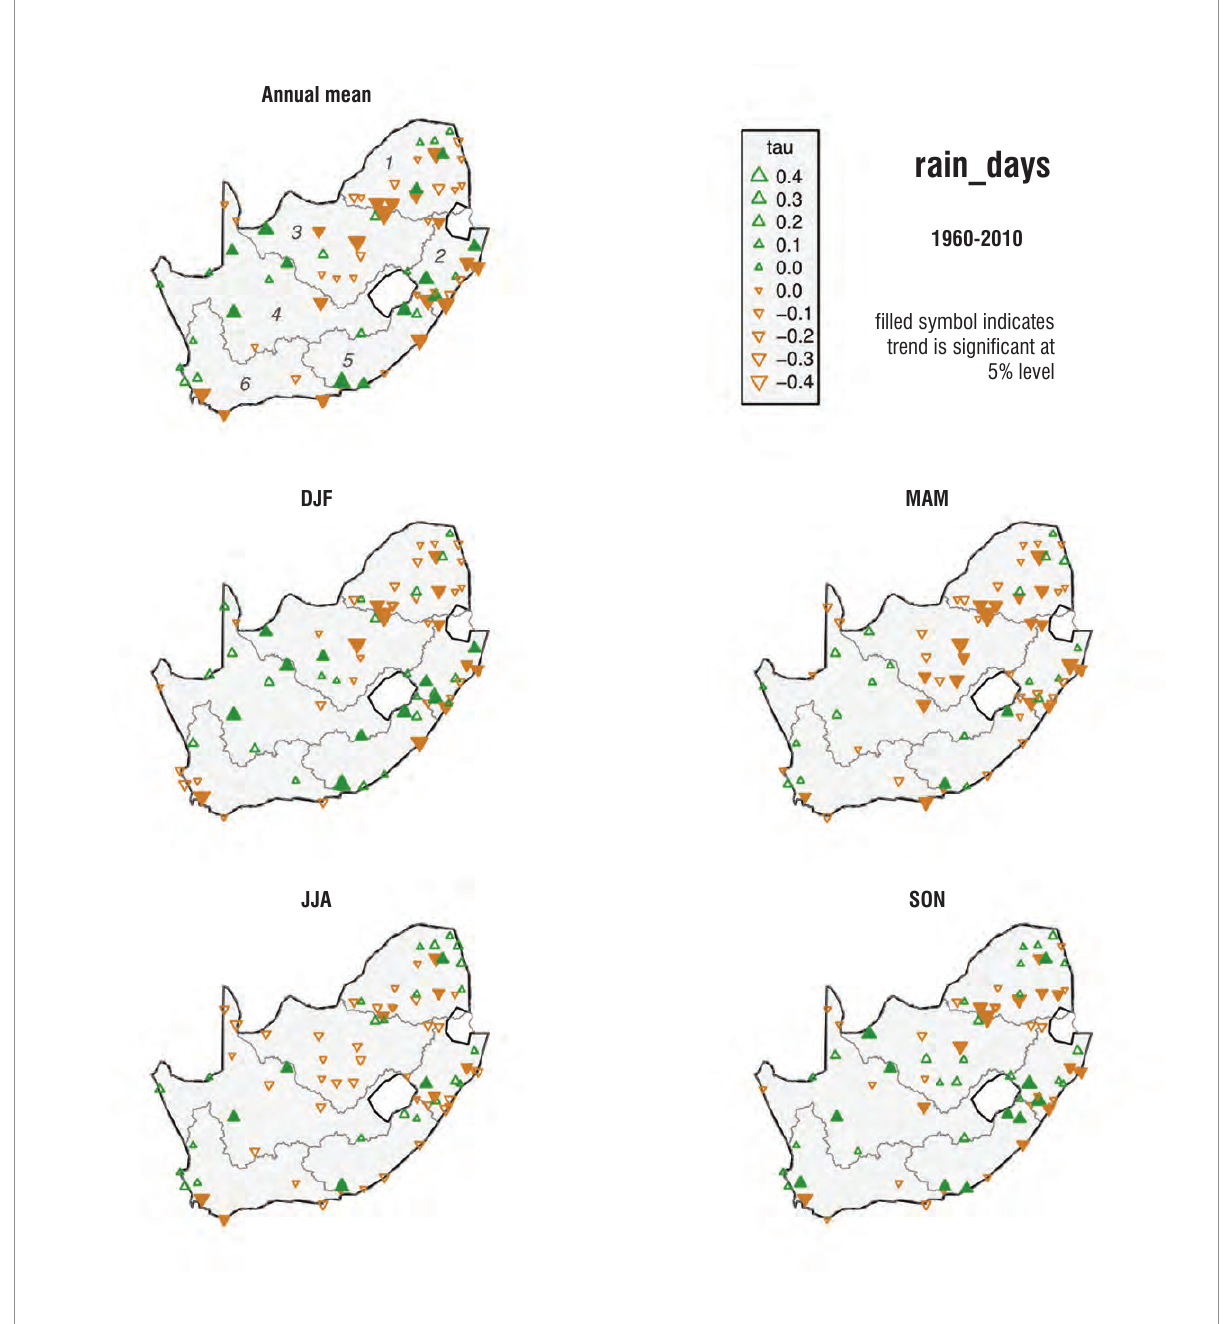
Figure 2: Trends in annual and seasonal rain days (days) for each station according to the Mann–Kendall test. The value of tau represents the direction and relative strength of the trend. Shaded symbols denote trends that are significant at the 5% level. Seasons are summer (DJF), autumn (MAM), winter (JJA) and spring (SON). Grey borders represent boundaries of the six water management regions, which are identified by number (1–6) in the annual mean this zone is highest for the MAM season (0.02 °C/year) and is 0.012 °C/ Data from only three temperature stations were available for this zone, year for the annual mean (Figure 7, second row). The increase in annual which all show positive trends for tmax (Figure 3) and tmin (Figure 4), mean tmin is 0.014 °C/year (Figure 8, second row). but not all of these trends are significant. No regionally averaged trends are seen in ppt (Figure 5, second row), but overall decreases in rain days Zone 3: Northern and central interior are shown in DJF and MAM and in the annual mean (Figure 6, second row). It must be noted, however, that spatial variability in the number of Opposing signals are shown at individual stations for ppt (Figure 1), with rain day trends for this zone is high, which the regional average does not a rough distinction between increased rainfall in the west and decreased take into account. The average increase in tmax for the three stations in rainfall in the east in DJF. There is, however, a general tendency for